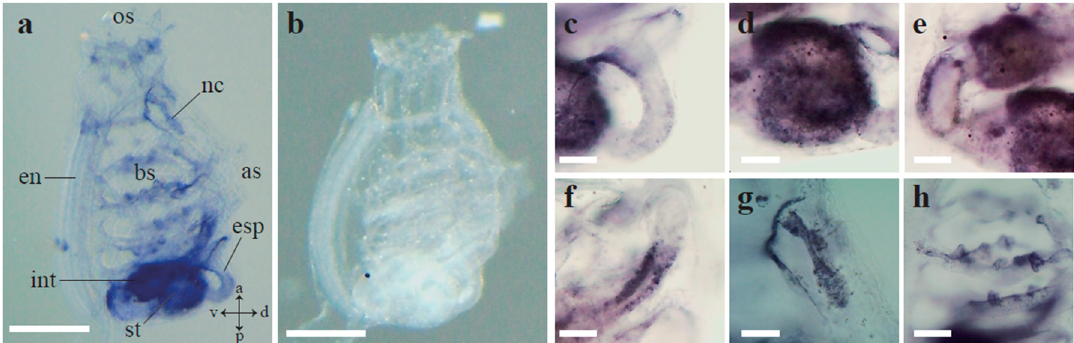
Figure 4. Whole-mount in situ hybridization (WISH) analysis of Ci-AhR mRNA in Ciona juveniles. ( a ) Ci-AhR mRNA localization using antisense Ci-AhR probe. ( b ) WISH analysis using sense probe of Ci-AhR . No signal was detected. Magnifications of ( a ) are presented in ( c – h ). a, anterior; as, atrial siphon; bs, branchial sac; d, dorsal; en, endostyle; esp, esophagus; int, intestine; nc, neural complex; os, oral siphon; p, posterior; st, stomach; v, ventral. Scale bars in ( a , b ) and ( c – h ) are 500 and 100 µ m, respectively.